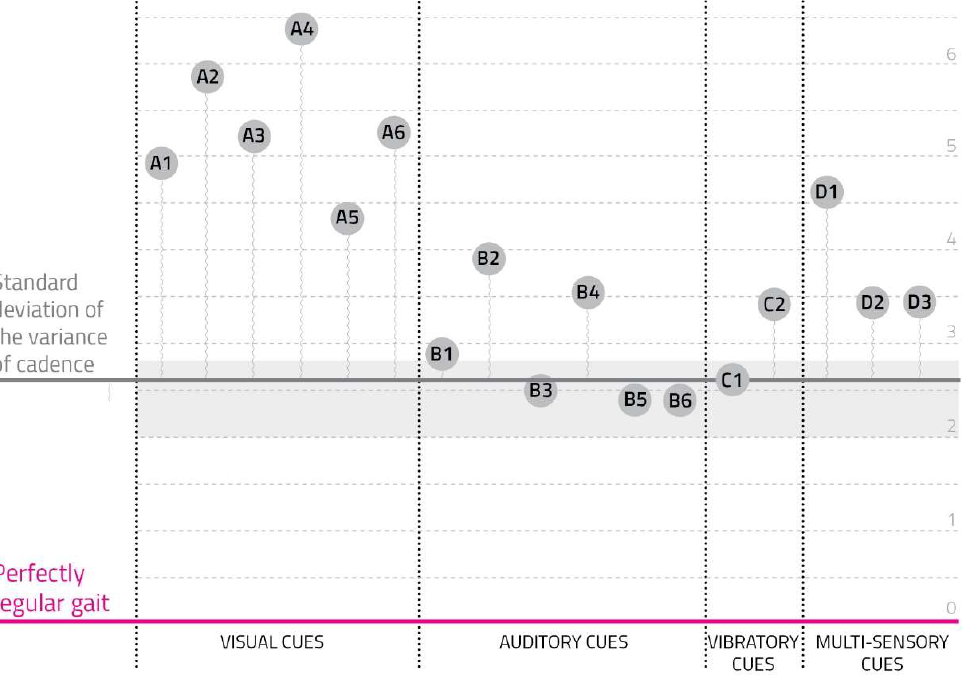
Figure 6. Users’ cadence variability. The gray section represents users’ standard deviation of the variance of cadence. Every cue prototype corresponds to a vertical line starting from the standard deviation of the user and ending with a circle where the cue obtained the furthest value.